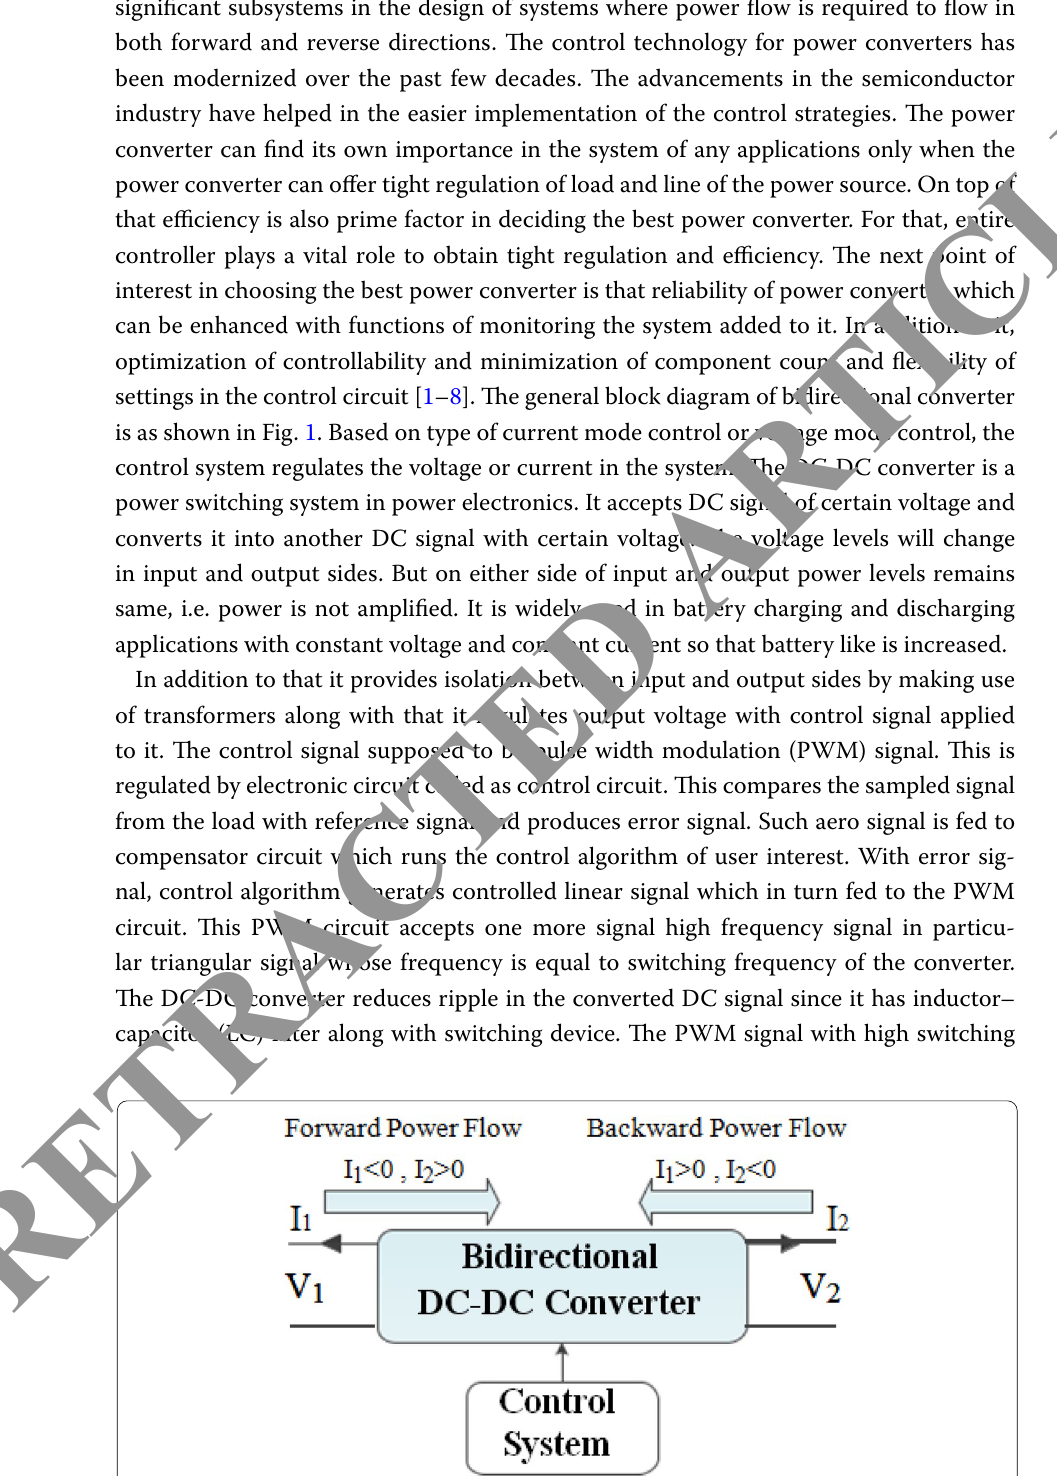
Fig. 1 The general structure of bidirectional DC-DC